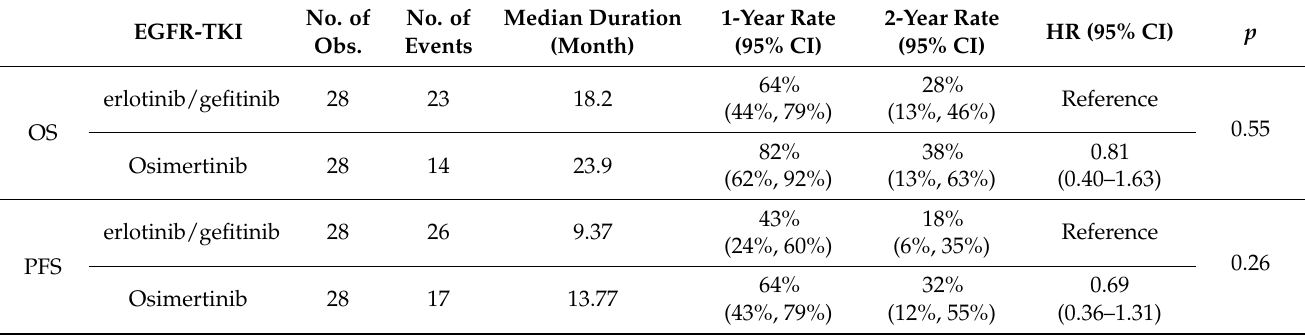
Table 12. Propensity score matching between first- and third-generation EGFR-TKI